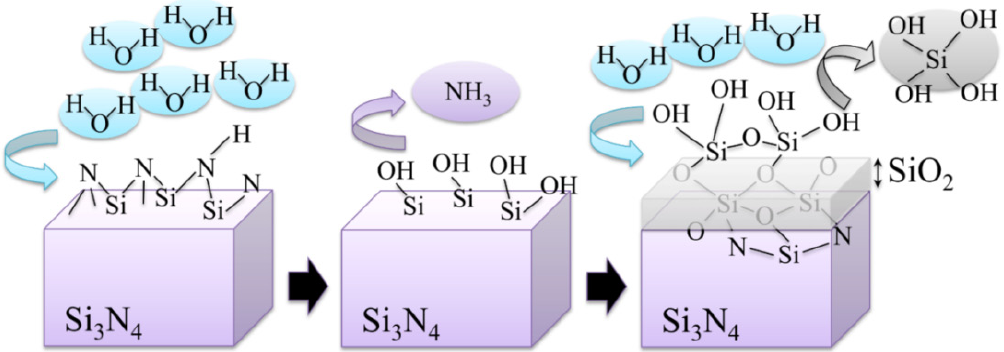
Figure 15. Behavior of a silicon nitride ceramic surface in a tribochemically active